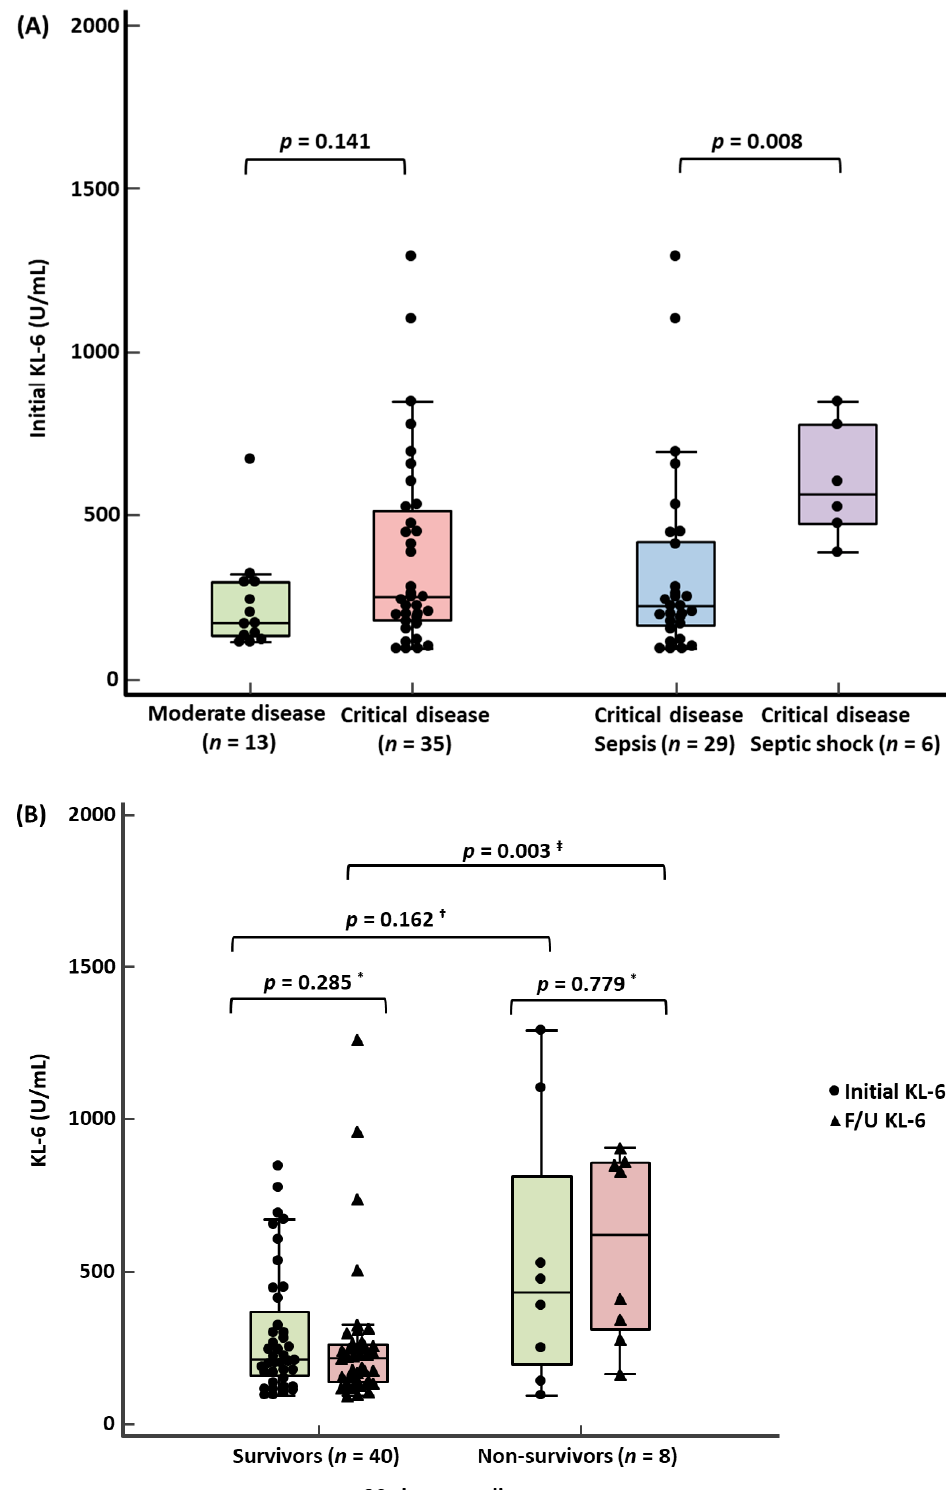
Figure 2. KL-6 levels according to WHO disease severity and 30-day mortality. ( A ) Initial KL-6 levels according to WHO disease severity. ( B ) Initial and F/U KL-6 levels according to 30-day mortality. * Wilcoxon signed-rank test between initial and F/U KL-6 levels. † Mann–Whitney test for initial KL-6 levels between survivors and non-survivors. ‡ Mann–Whitney test for F/U KL-6 levels between survivors and non-survivors. Abbreviations: KL-6, Krebs von den Lungen-6; and F/U, follow-up.